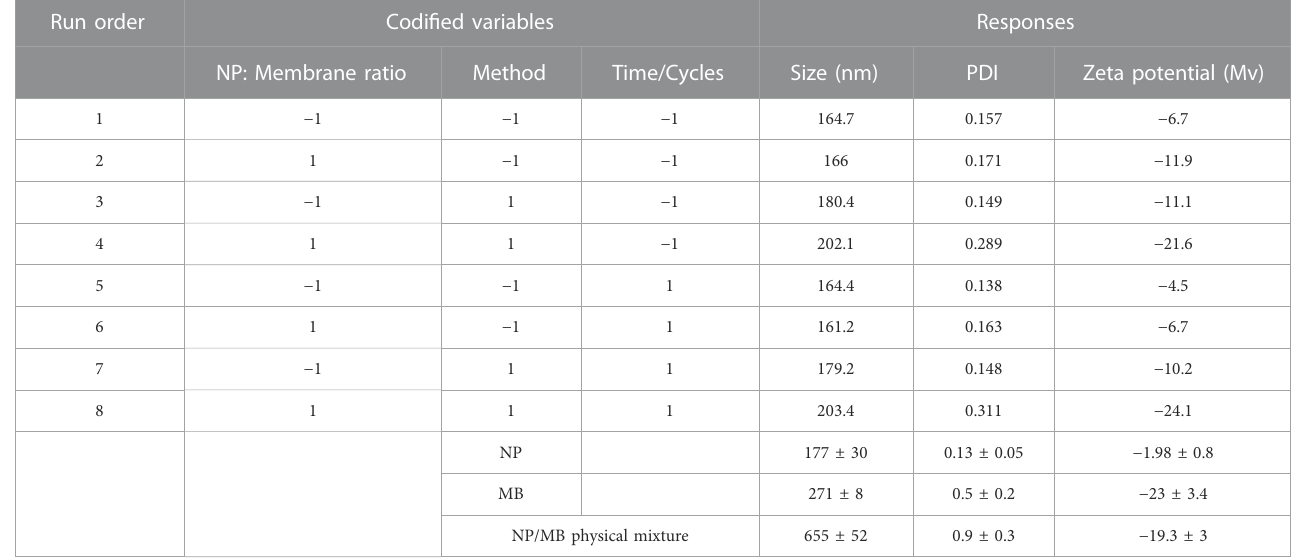
TABLE 3 Codi fi ed variable composition of complete factorial design (2 3 ) and acquired results regarding the optimization of membrane cell-derived hybrid nanostructures development. Run